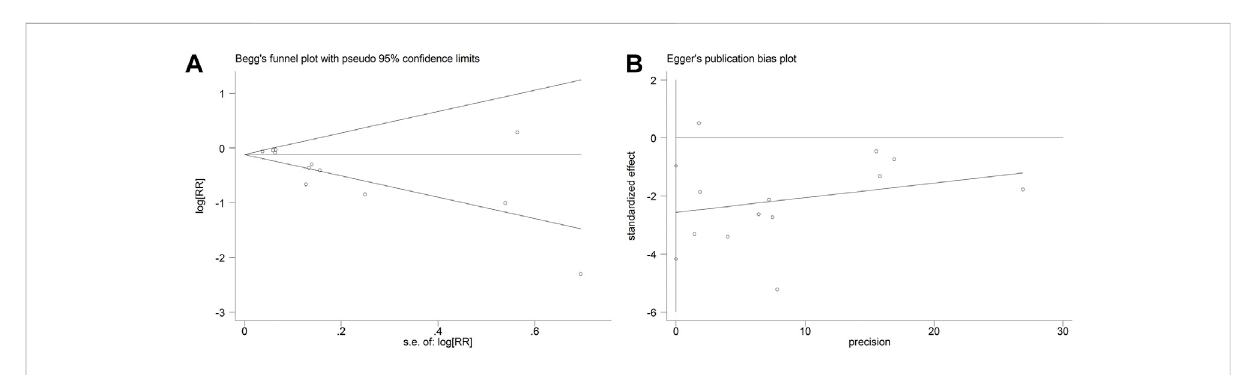
FIGURE 6 Begg ’ s rank correlation test (A) and Egger ’ s regression asymmetry test (B)